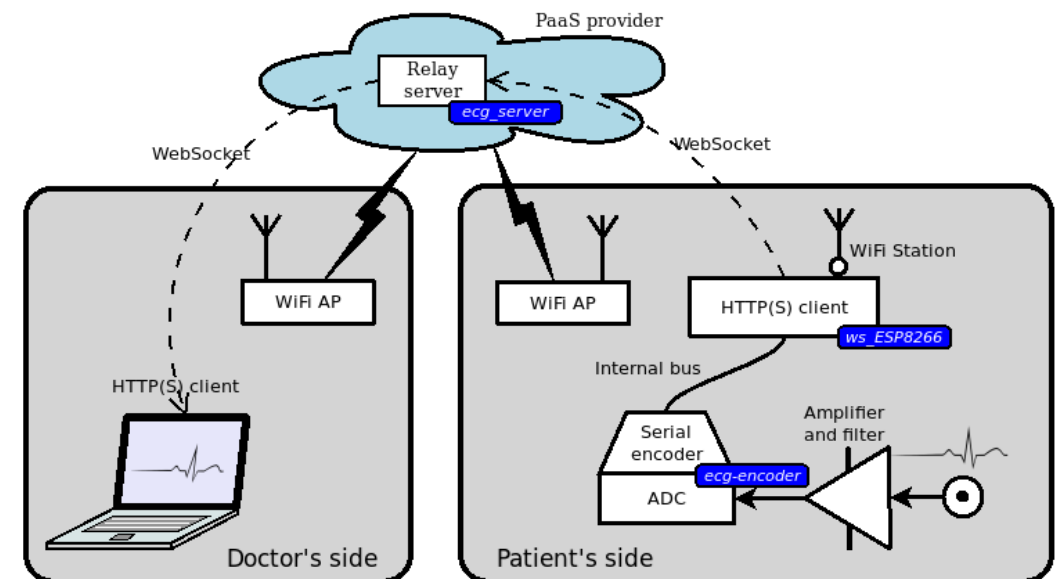
Figure 2. Remote electrocardiogram (ECG) service overview; blue labels refer to code in the repository [24].